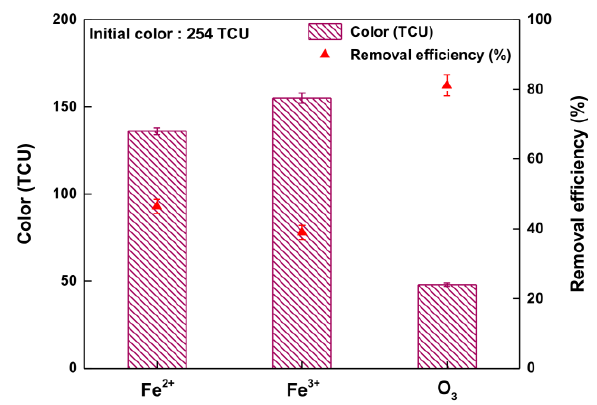
Figure 2. Removal efficiency of color of Fenton (Fe 2+ ), Fenton-like (Fe 3+ ), and O 3 oxidation.